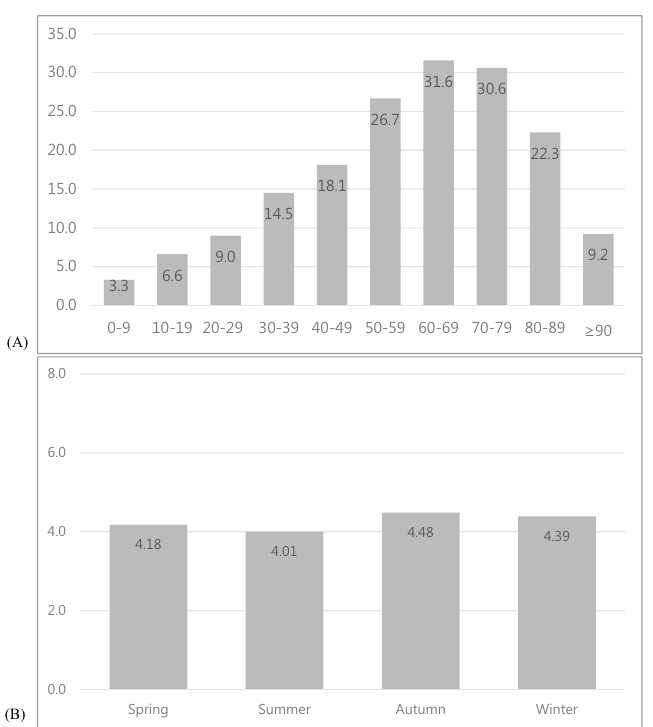
Figure 1. Incidence of Bell’s palsy by age group ( A ) and seasons ( B ) (2010–2018, per 100,000 persons, descriptive statistics).